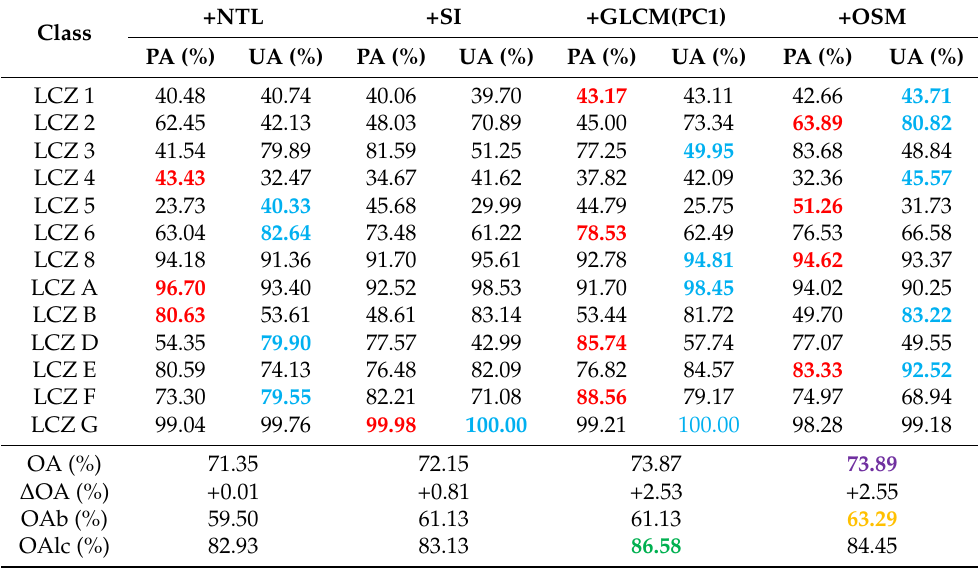
Table 6. The accuracy comparison of adding any one of secondary datasets to the basic combination. Table